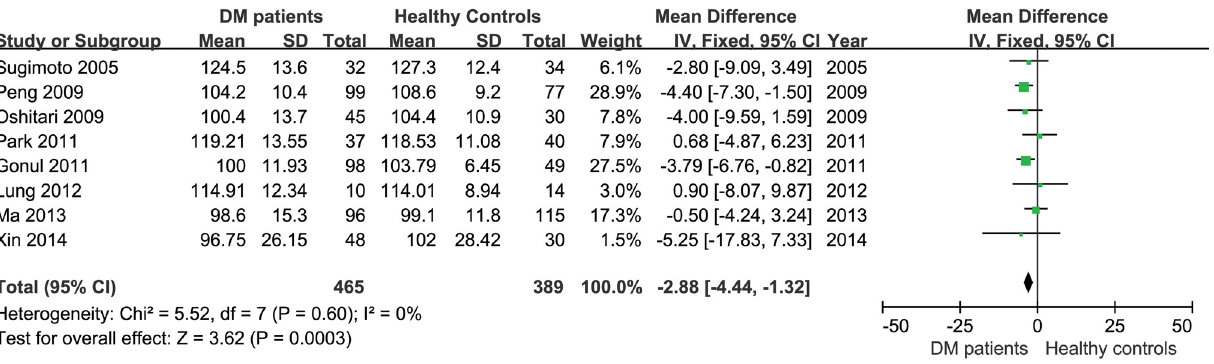
Fig 2. Meta-analysis of average RNFL thickness of diabetic patients and healthy controls in studies using